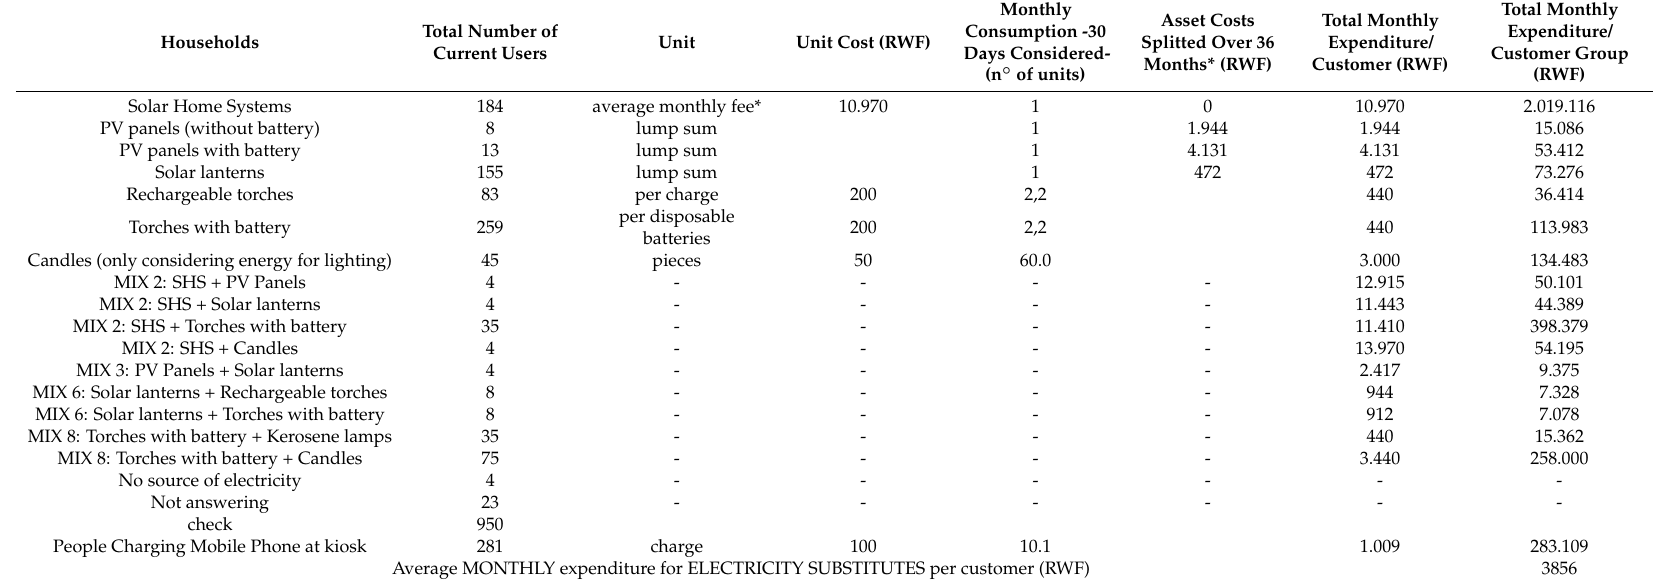
Table 7. Calculation of the average monthly expenditure from electricity substitutes per